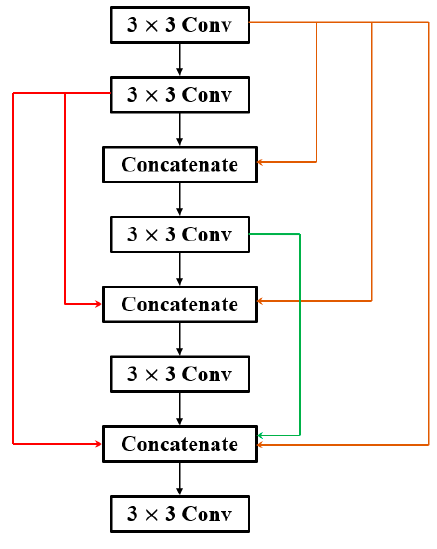
Figure 7. Building block of DenseNet. Table 3. Network architecture for citrus pests and diseases.